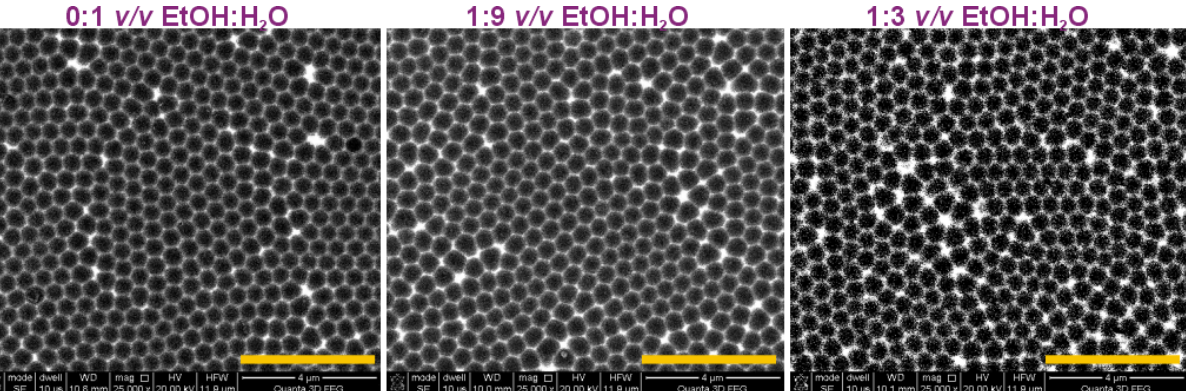
Figure 3. SEM images of Al substrates after dissolution of anodic alumina formed in I anodization, performed in 0.3 M etidronic acid solutions without (0:1 v / v EtOH:H 2 O) and with two different amount of ethanol: 1:9 v / v EtOH:H 2 O and 1:3 v / v EtOH:H 2 O (the yellow scale bar = 4 µm).